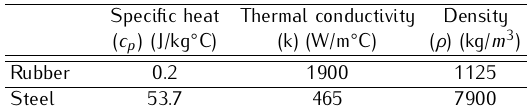
Table 3. Thermal properties of the